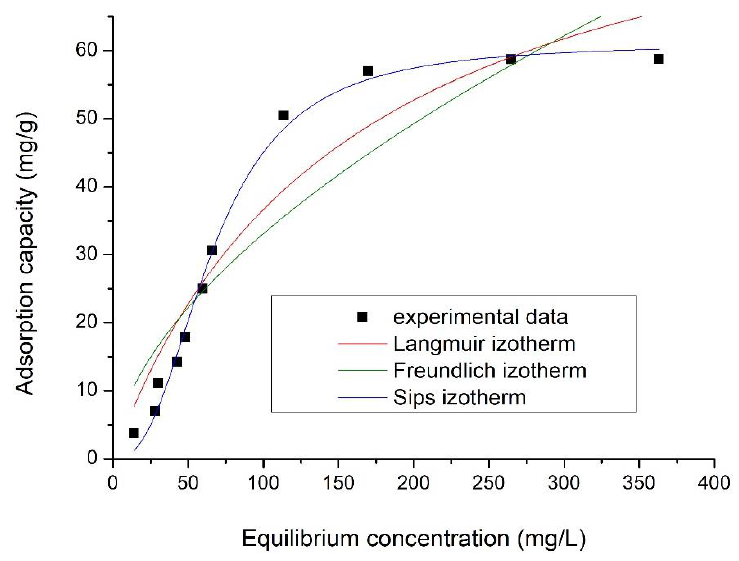
Figure 14. Equilibrium isotherms for SiO 2 FexOy sample. Specific parameters associated with each adsorption isotherm used to model obtained experimental data were calculated from slopes of the straight line, and respectively, using the ordinate from the origin (Table 6). Table 6. Isotherm parameters. Langmuir Isotherm